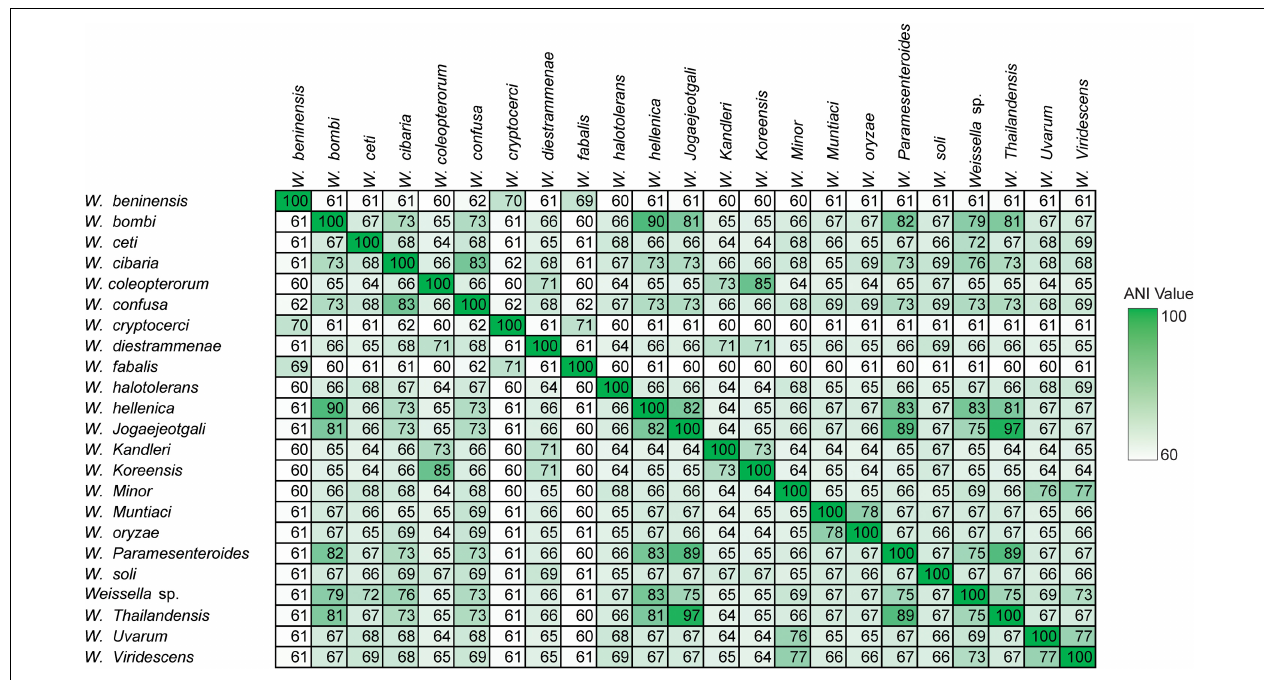
FIGURE 3 | Interspecies similarities among the genus Weissella